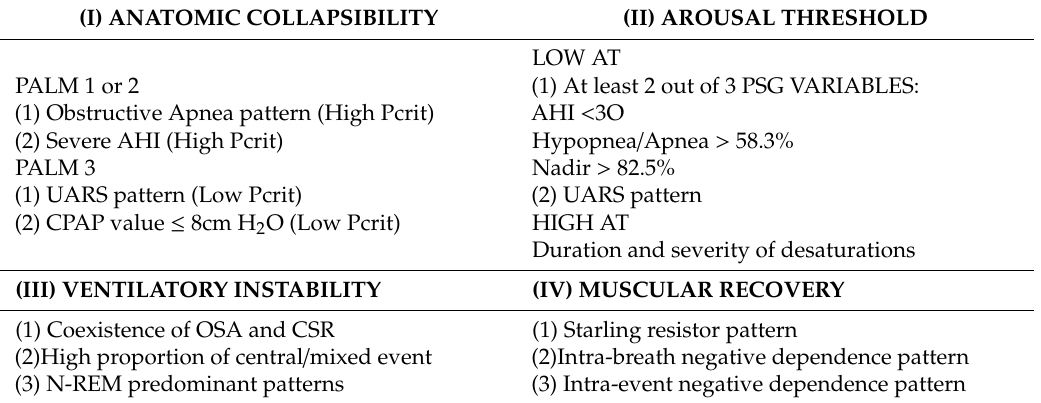
Table 1. List of patterns and polysomnographic (PSG) variables allowing a qualitative assessment of pathophysiological